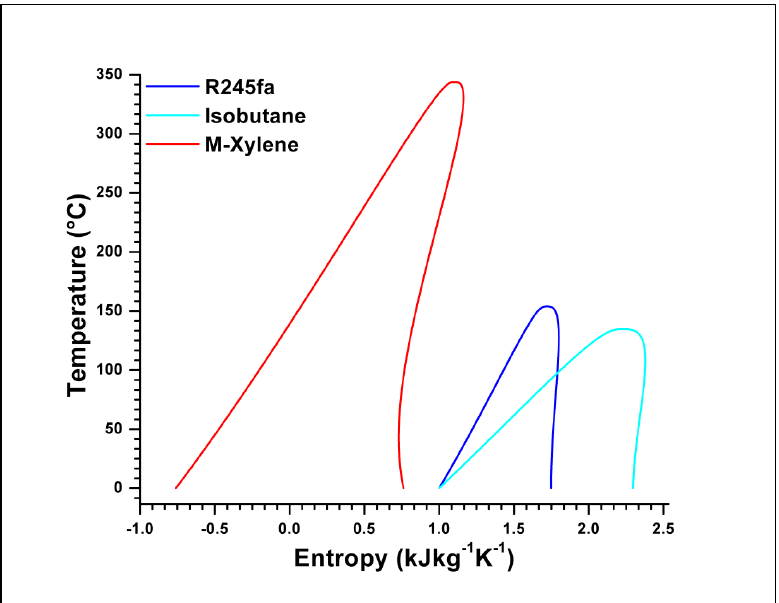
Figure 2. Temperature - entropy diagram of the working fluids considered in present